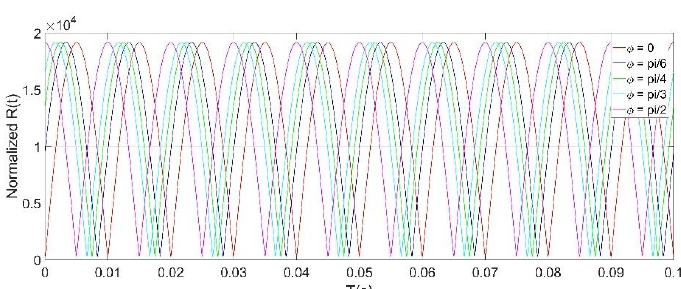
Figure 8. Normalized simulation results of R ( t ) under different initial phase φ values, ω e = 2π 50 rad/s, ω s = 2π 3050 rad/s.